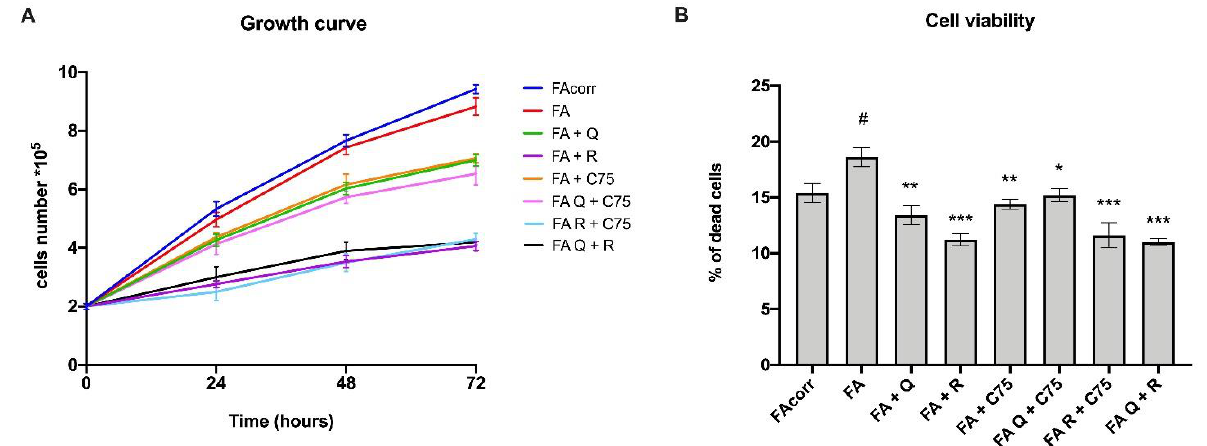
Figure 1. Reduced cell growth and dead in FA cells treated with quercetin, rapamycin, C75, and their combinations. ( A ) Cell growth curves. ( B ) Percentage of dead cells at 48 h. (Q = quercetin alone; R = rapamycin alone; C75 = C75 alone; Q + C75 = quercetin/C75 combination; R + C75 = rapamycin/C75 combination; Q + R = quercetin/rapamycin combination). Each graph represents four independent experiments and data are expressed as mean ± S.D. For FA and FA-corr cells, data are representative of four different Fanc-A lymphoblast cell lines. Statistical analysis was performed via one-way ANOVA followed by Tukey multiple comparison test. # indicates a p < 0.05 between FA cells and FA-corr cell lines; *, **, or *** indicate a p < 0.05, 0.01, or 0.001, respectively, between untreated and treated FA cells.